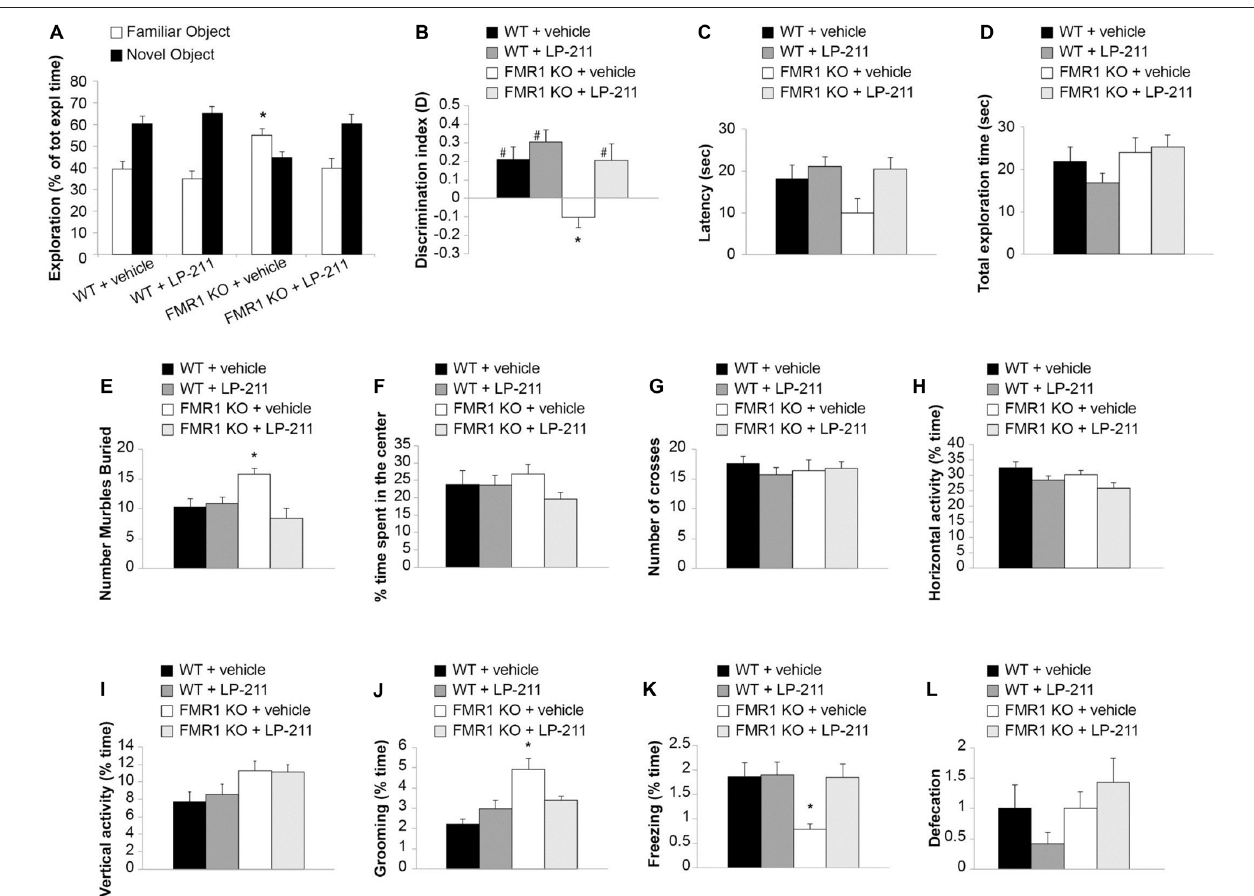
FIGURE 6 | Acute in vivo administration of LP-211 improved memory and reduced stereotyped behavior in Fmr1 KO mice. (A) Exploration times of familiar and novel object during T2 (after a 24-h retention interval) show that Fmr1 KO mice treated with vehicle present an impairment of memory (higher amount of time exploring the familiar vs. the novel object; p < 0.0001) that is rescued by treatment with LP-211 (3 mg/kg 30 min before T1). WT + vehicle = 11; Fmr1 KO + vehicle = 12; WT + LP-211 = 10; Fmr1 KO + LP-211 = 10. (B) Analysis of the discrimination (D) index confirms that the impairment of recognition memory in Fmr1 KO ( P = 0.015 vs. WT) is rescued by LP-211 ( P = 0.02 vs. Fmr1 KO + LP-211). A difference from 0 is depicted with hashes ( # p < 0.05) (C) Latency to first approach to the novel object and (D) total exploration time are comparable in the 4 groups of mice. (E) Fmr1 KO treated with vehicle buried a higher number of marbles compared to WT ( P = 0.002). This stereotypic behavior was rescued by treatment with LP-211 (3 mg/kg 30 min before test). WT + vehicle = 11; WT + LP-211 = 10; Fmr1 KO + vehicle = 12; Fmr1 KO + LP-211 = 10 for novel object recognition (NOR; A–D ) and Marble Burying (E) tasks. (F) Time spent in the center of the arena and (G) the number of crosses into the center is comparable in the four groups of mice. (H–I) General locomotor activity analyzed as horizontal activity and vertical activity (rearing) is not modified by genotype and treatment. (J) The increase in stereotyped behavior such as grooming in Fmr1 KO mice ( P < 0.0001) is rescued by treatment with LP-211. (K) Fmr1 KO mice show a decrease of spontaneous freezing behavior compared to WT littermates ( P = 0.036) that is rescued by LP-211. (L) Defecation is comparable in the four groups of mice. WT + vehicle = 10; WT + LP-211 = 12; Fmr1 KO + vehicle = 12; Fmr1 KO + LP-211 = 14 for Open field (OF) test. Data are expressed as mean ± SEM. ∗ Significant difference ( p < 0.05 by one-way ANOVA with Bonferroni’s multiple comparisons test); # difference with zero (one-sample t